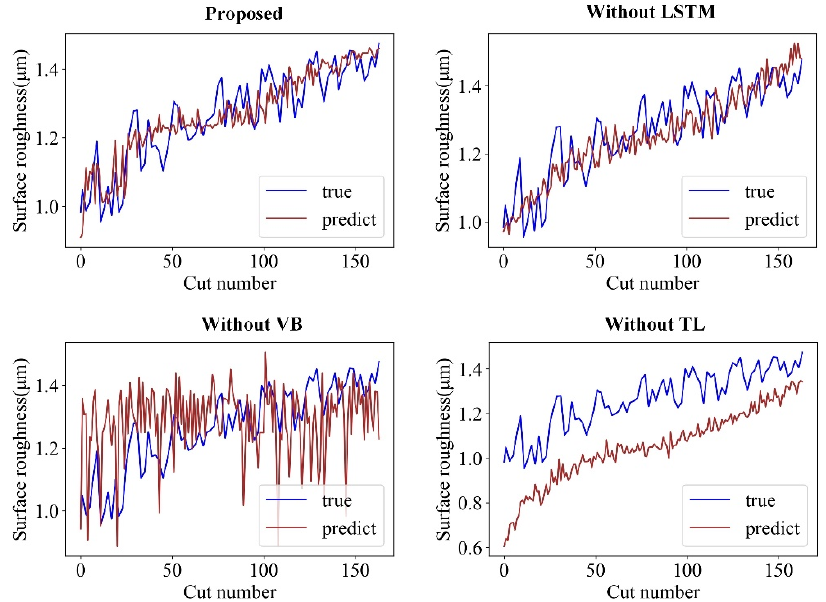
Figure 16. Prediction effect of different models on CT3-2 under the T2 task.